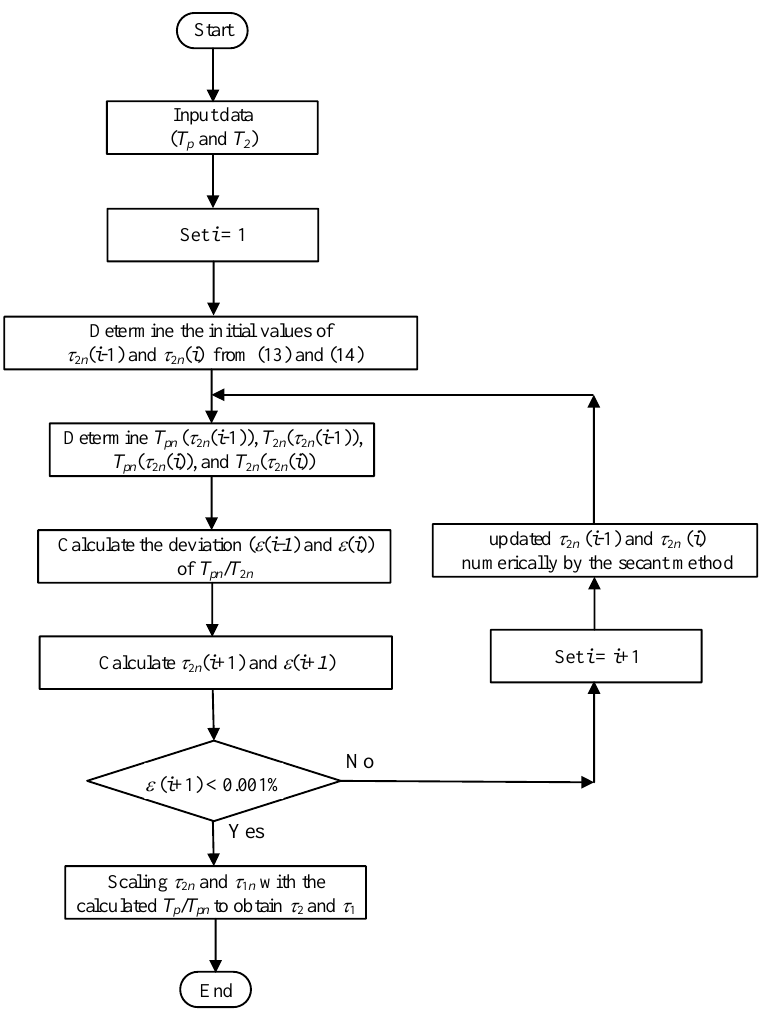
Figure 3. Algorithm used for generation of the impulse switching waveform with the specified T 2 and T p .